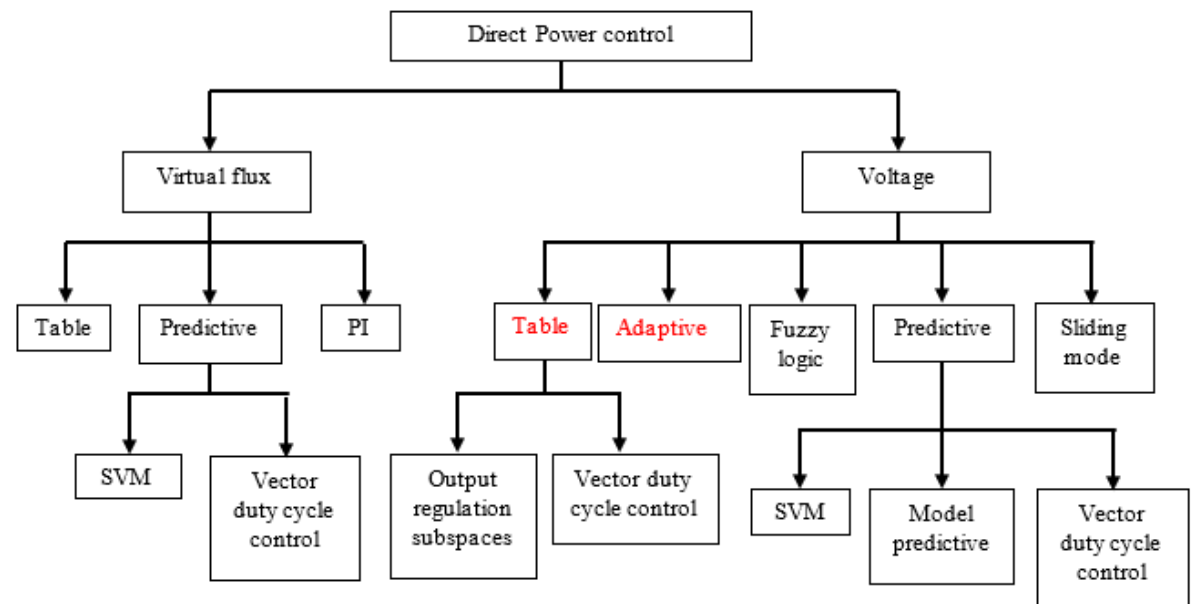
Figure 6. Different control strategies based on the DPC principle.